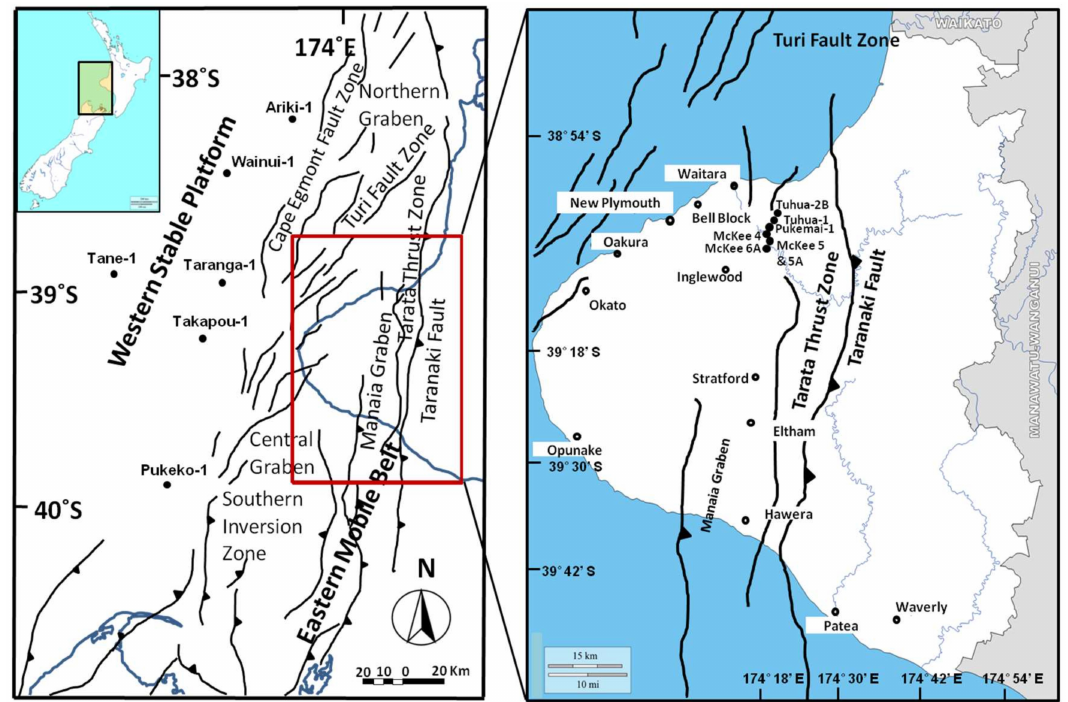
Figure 1. Location of Taranaki Basin with its major structures and studied well locations onshore; Modified after [7], from AAPG© (2011) and reprinted by permission of the AAPG whose permission is required for further